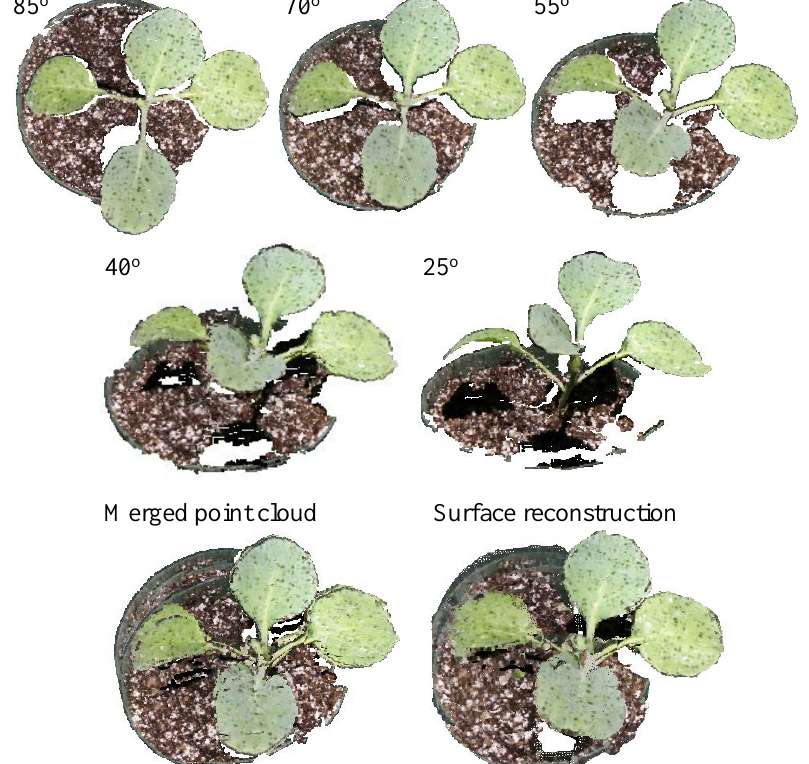
Figure 7. Point clouds from different view angles (top row) and their merged point cloud and surface reconstruction results (bottom